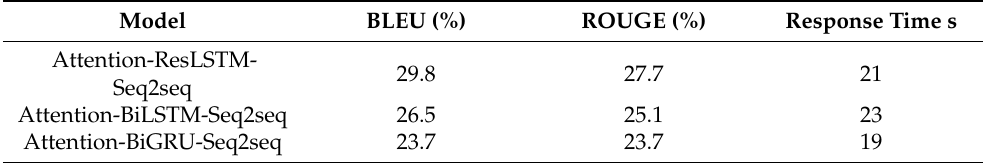
Table 9. Comparison of response time and effect of three network